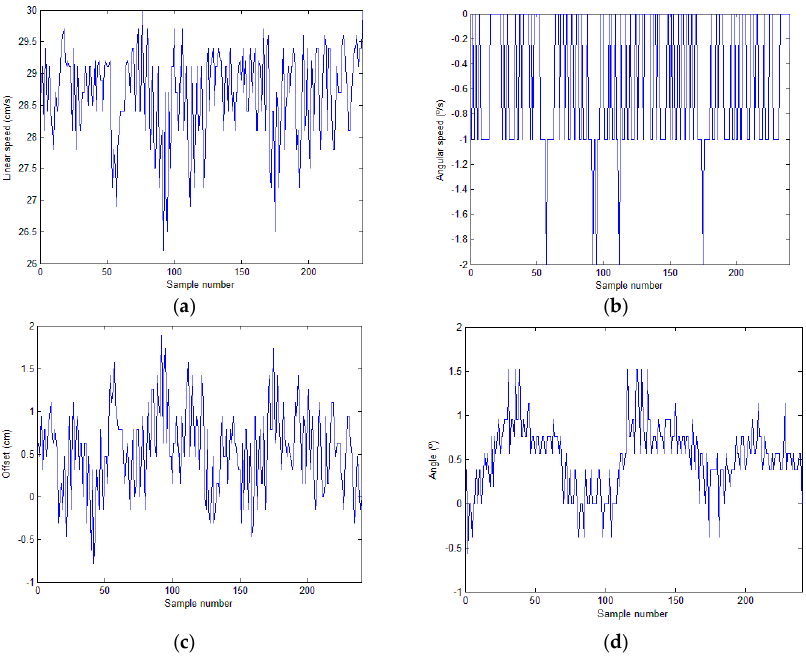
Figure 17. First test environment: ( a ) Evolution of the linear speed of the robot. ( b ) Evolution of the angular speed of the robot. ( c ) Evolution of the offset of the robot relative to the line. ( d ) Evolution of the angle of the robot relative to the line.